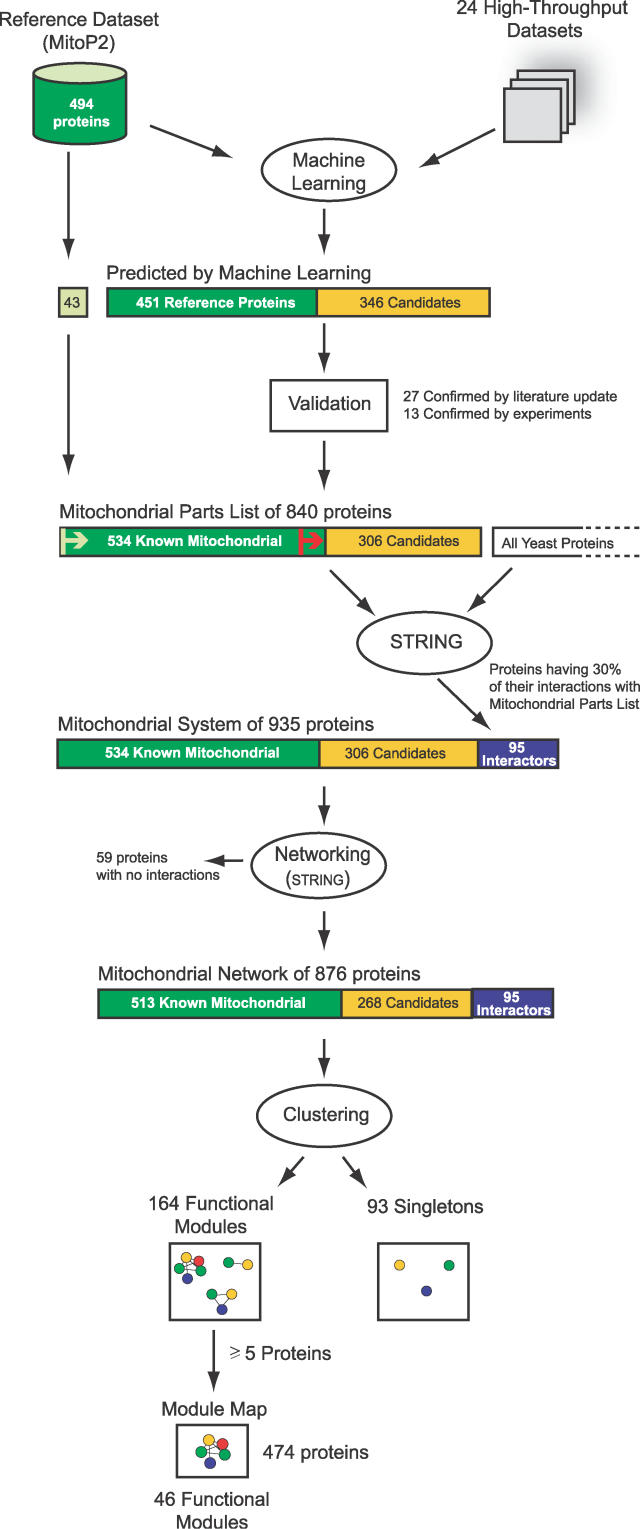
Summary of the Integrated Approach